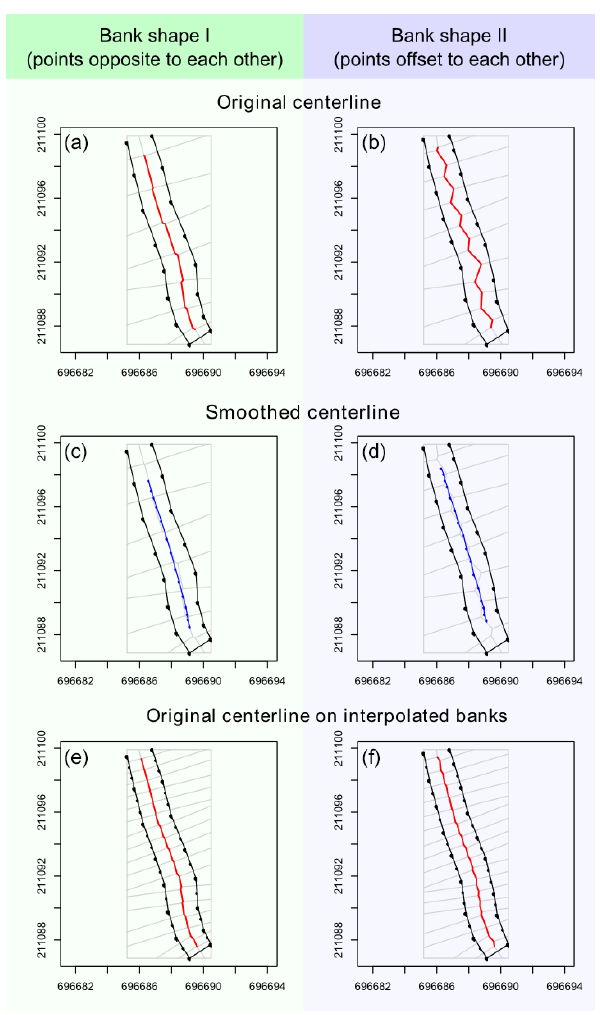
Figure 2. The plot shows two digitizations (bank shapes I and II) of the same channel stretch. They differ only in the arrangement of bank points, which are mainly opposite (bank shape I; a , c , e ) or off- set (bank shape II; b , d , f ) to each other. One can see how the offset negatively influences the shape of the centerline (a, b) . The problem can be overcome by smoothing the centerline a posteriori (c, d) or interpolating between the bank points a priori (e, f) . A combination of both methods is recommended and set as the default in cmgo.